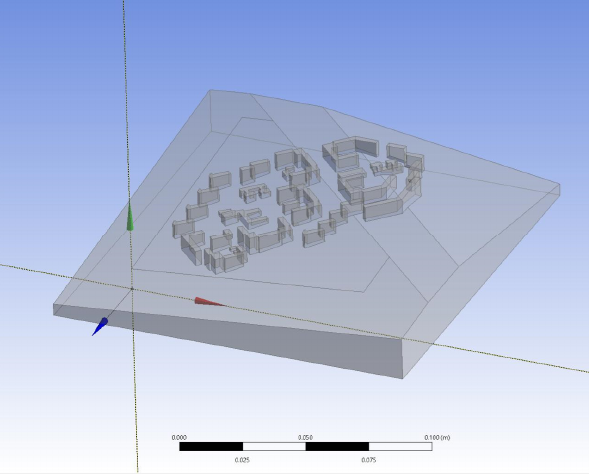
Figure 21. Computational model for mathematical simulation of aeration regime in ANSYS Fluent. Further, boundary and initial calculation conditions were set. Boundary